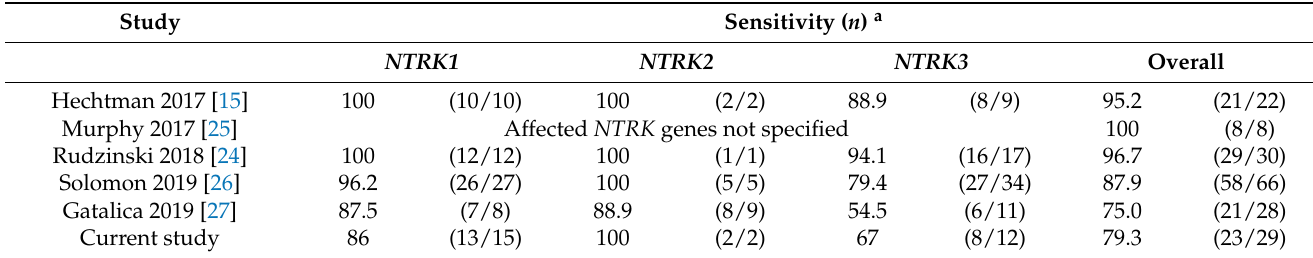
Table 3. Sensitivity of TRK immunohistochemistry as a screening tool to detect NTRK fusions, according to published